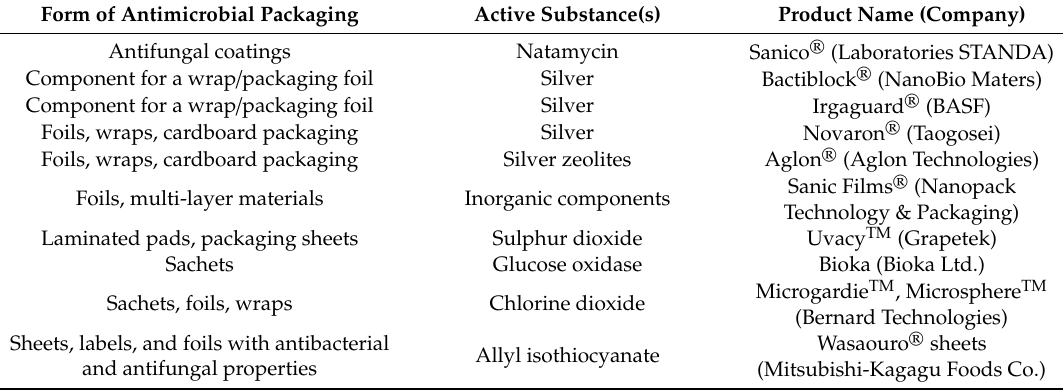
Table 1. Examples of commercially available antimicrobial packaging for food. Form of Antimicrobial